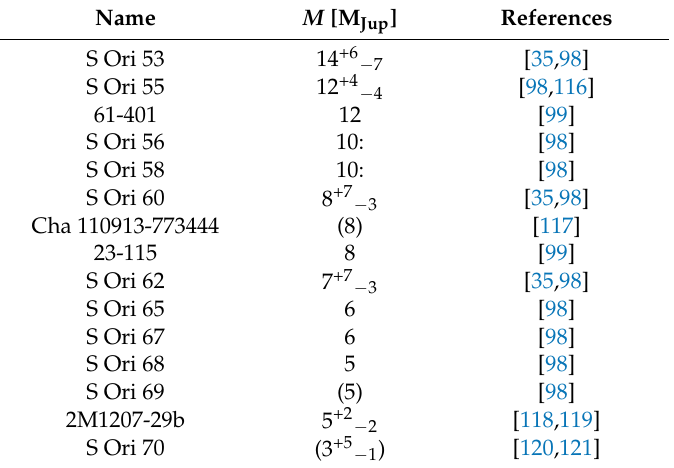
Figure 4. Mosaics of I -band images of σ Orionis taken with the Wide Field Camera on the 2.5 Isaac Newton Telescope showing the location of some iPMO candidates in [35]. The size of each small inset picture is 2 × 2 arcmin 2 ; the size of each Wide Field Camera frame is about 11 × 22 arcmin 2 ; the size of the background image from Digitized Sky Survey II Infrared is 1 × 1 deg 2 . Image courtesy of the author. Table 1. iPMO candidates with published spectroscopy before 2006 1 .